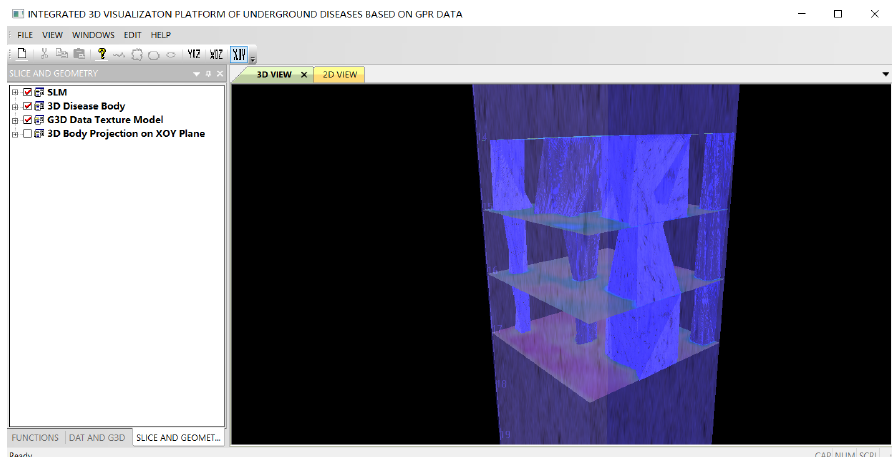
Figure 16. 3D visualization of geohazards.